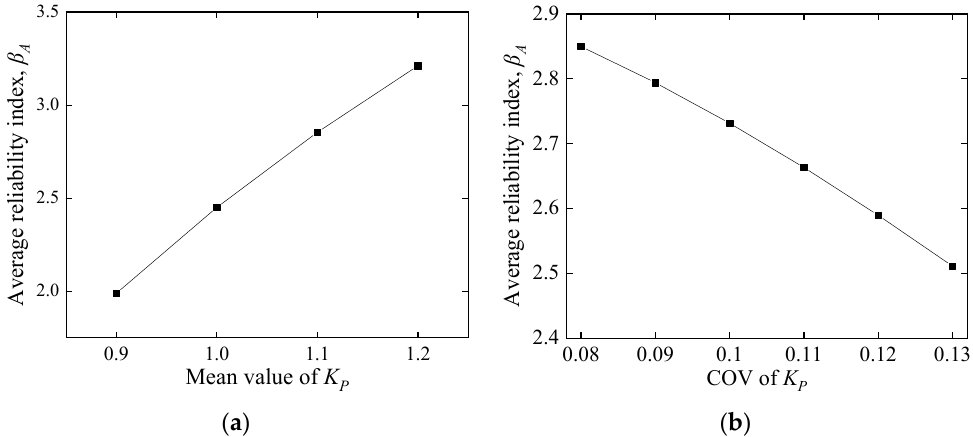
Figure 14. Effect of the model uncertainty factor on the average reliability index. ( a ) Effect of mean value of Kp on β A, ( b ) effect of COV of Kp on β A.